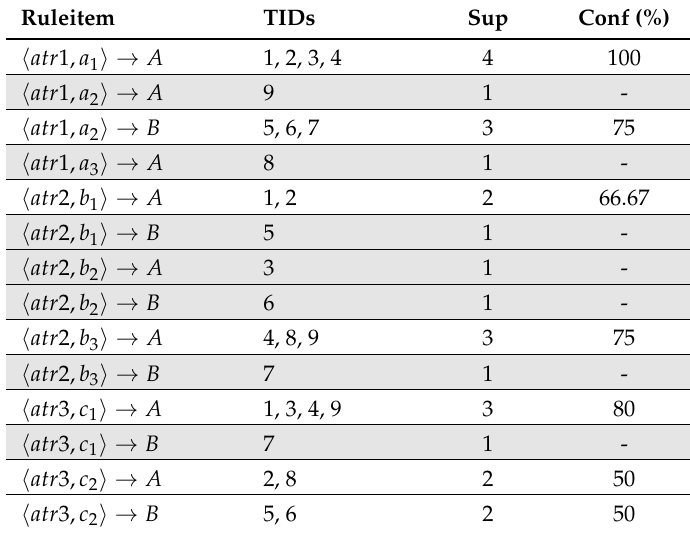
Table 3. The rules that meet minimum support threshold (white background cell).